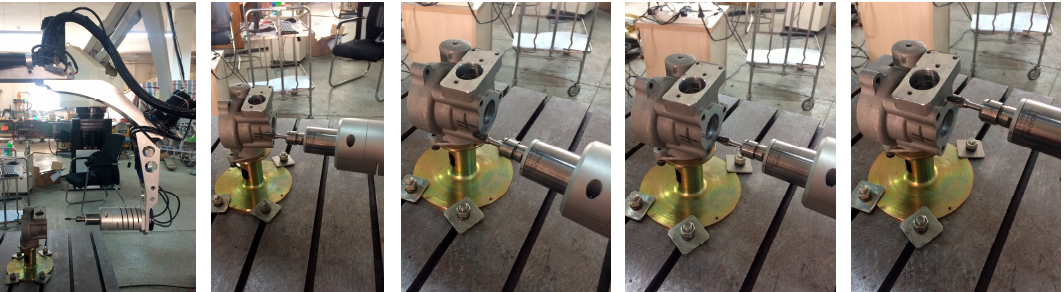
Figure 24. Experimental deburring of orifice edges on distal side facet.